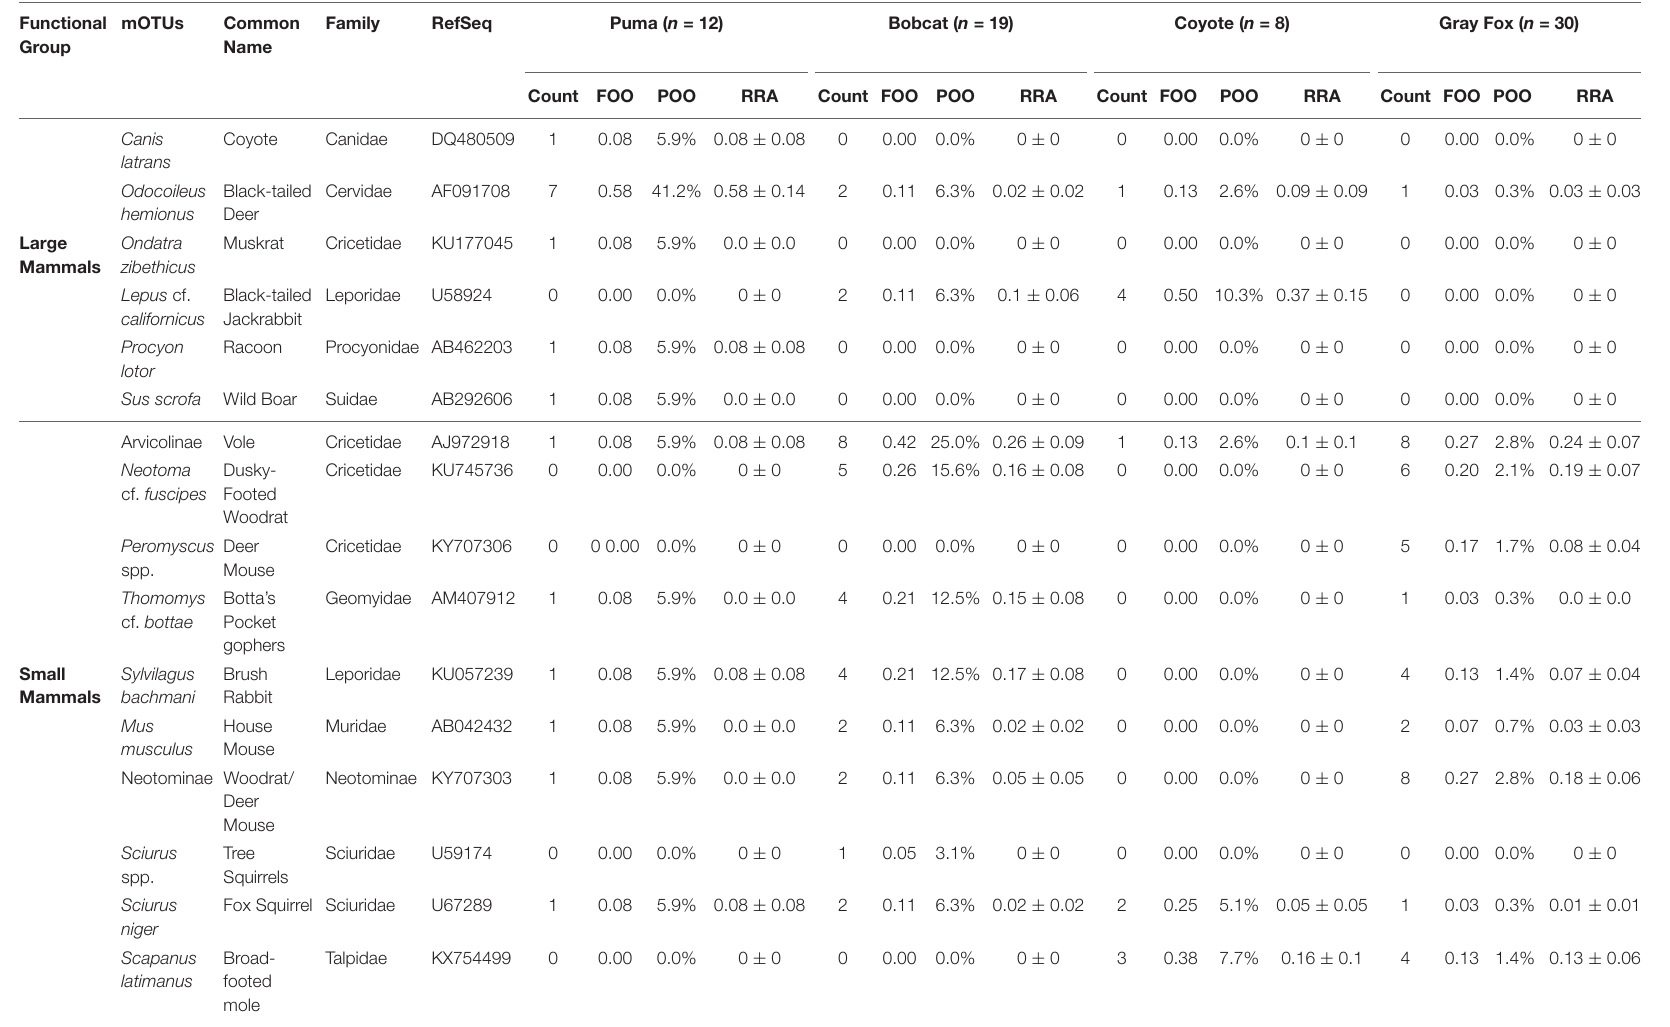
TABLE 2 | Mammal diet mOTUs found within scats from four predator species collected from JRBP, expressed by the Count (number of scats containing prey species); FOO (frequency of occurrence = number of occurrences/total scat sample size); POO (percentage of occurrence = number of occurrences/total number of prey species across all samples); and RRA (mean relative read abundance = number of reads per species/total number of reads per scat